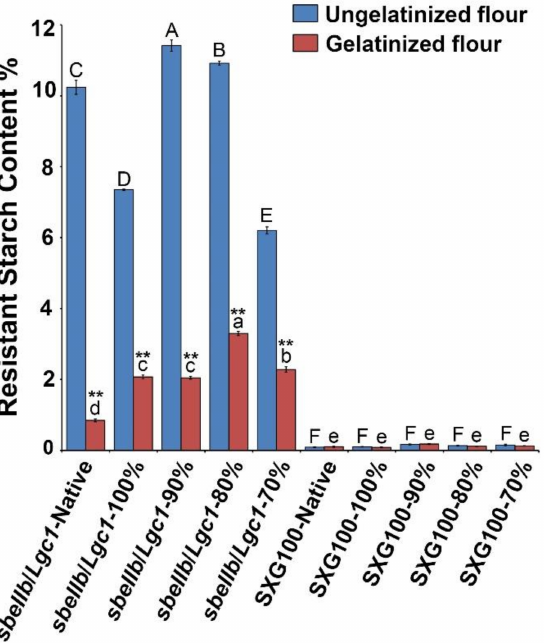
Figure 1. Resistant starch contents of native and HMT rice flours of sbeIIb / Lgc1 and SXG100. All the analyses were repeated three times. Data are presented as mean ± standard derivation. ANOVA and the least significant difference method were used to conduct statistical analyses of gelatinized or ungelatinized flours. Different uppercase letters represent the significant difference of RS content of ungelatinized flours, while different lowercase letters represent those of gelatinized flours. p < 0.01 was considered as being significantly different. A two-tailed t -test was used to conduct statistical analyses of gelatinized and ungelatinized treatments under the same condition. ** represents p <